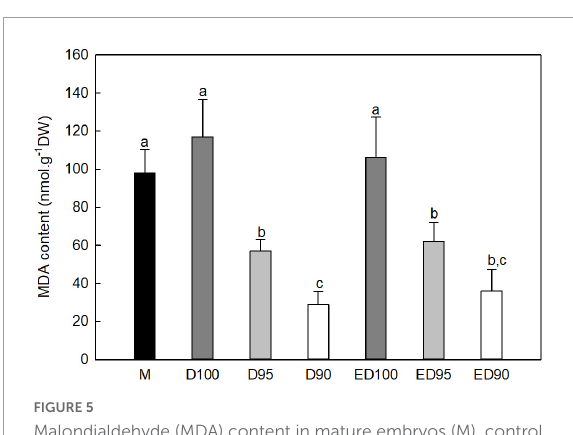
FIGURE5 Malondialdehyde (MDA) content in mature embryos (M), control embryos at half (D100) and at the end (ED100) of treatment with 100% relative humidity, and embryos exposed to 95 and 90% relative humidity during the first half of desiccation (D95 and D90) and subsequently transferred to 100% relative humidity (ED95 and ED90). Values are given as means ± standard deviations of four independent experiments ( n = 8). Different letters indicate a statistically significant difference at p ≤